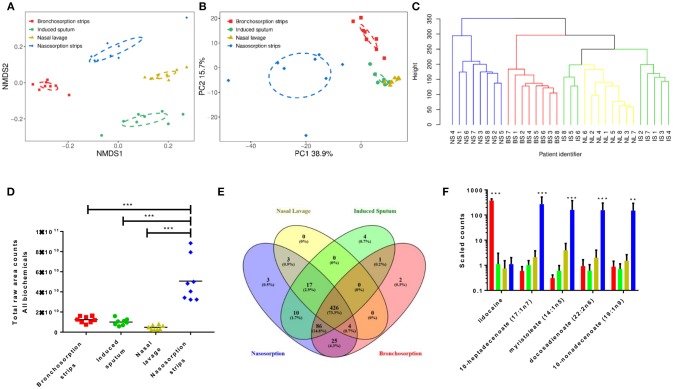
Different airway sampling techniques have distinct airway metabolomic profiles. Upper and lower airway surface liquids were sampled from eight healthy volunteers using bronchosorption strips (red), induced sputum (green), nasal lavage (yellow) and nasosorption strips (blue). Quantitative metabolic profiling by UPLC-MS/MS was performed on each airway sample, yielding 581 known compounds. Non-metric multidimensional scaling (A) and principle component analysis (B) were used on pre-scaled data to visualize the overall metabolomic composition of each airway sample. Hierarchical clustering analysis of similarities in metabolomic composition between individual samples and sampling sites (branches colored by sample site post clustering analysis) (C). Total raw area counts for all detected biochemicals (D). Venn diagram of individual biochemical identities by sampling method (E). Individual analytes with highest variance between sampling methods (F) **p < 0.01 *** p < 0.001 between largest group and others. n = 8 volunteers.